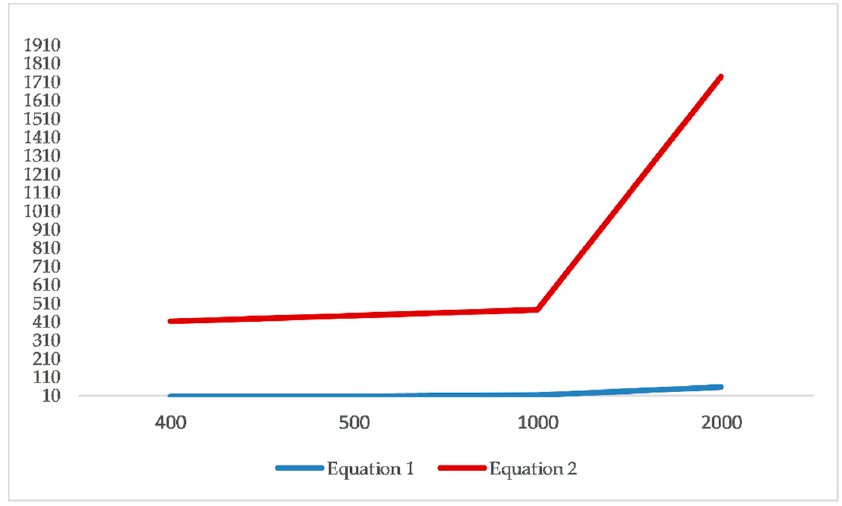
Figure 10. The CON CoAP GET performance comparison between Equations (1) and (2).